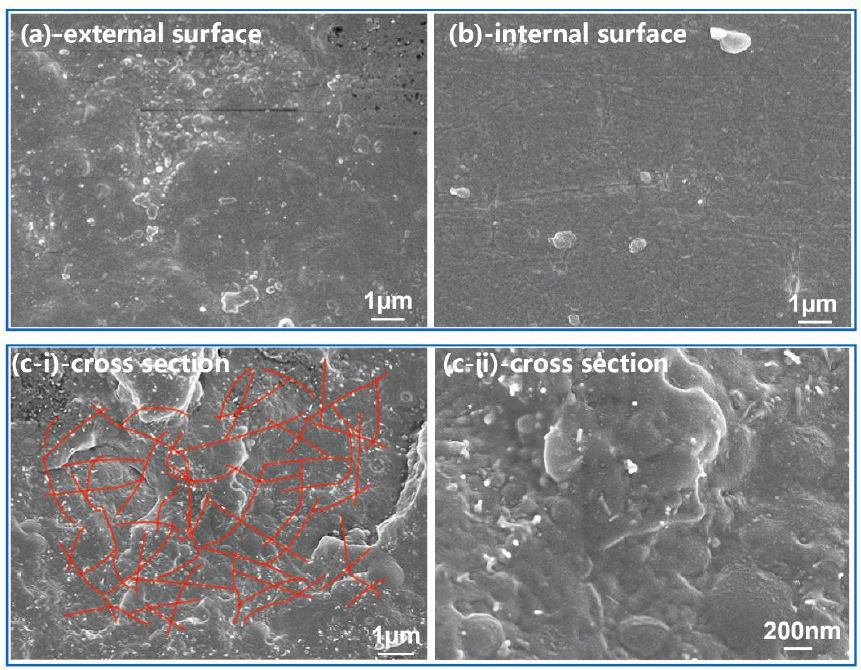
Figure 5. The morphology of the outside and internal surface ( a , b ) and cross-section surfaces ( c ) for fuel pipes with 3 wt% MWCNTs.